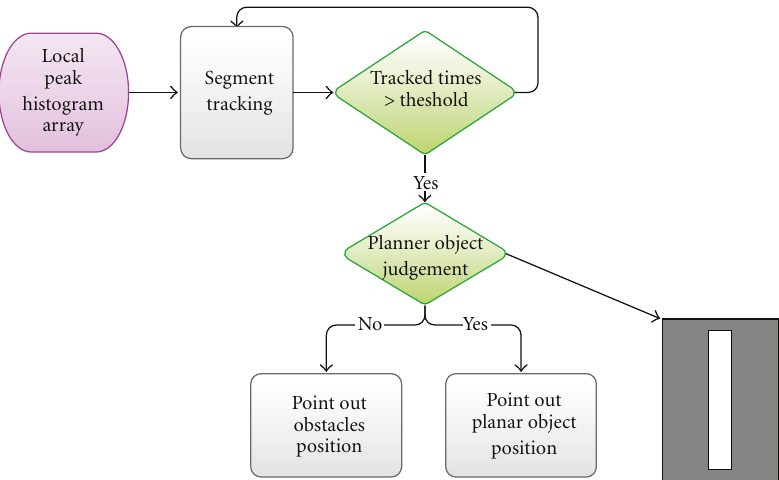
Figure 18: The flow chart of object tracking and information